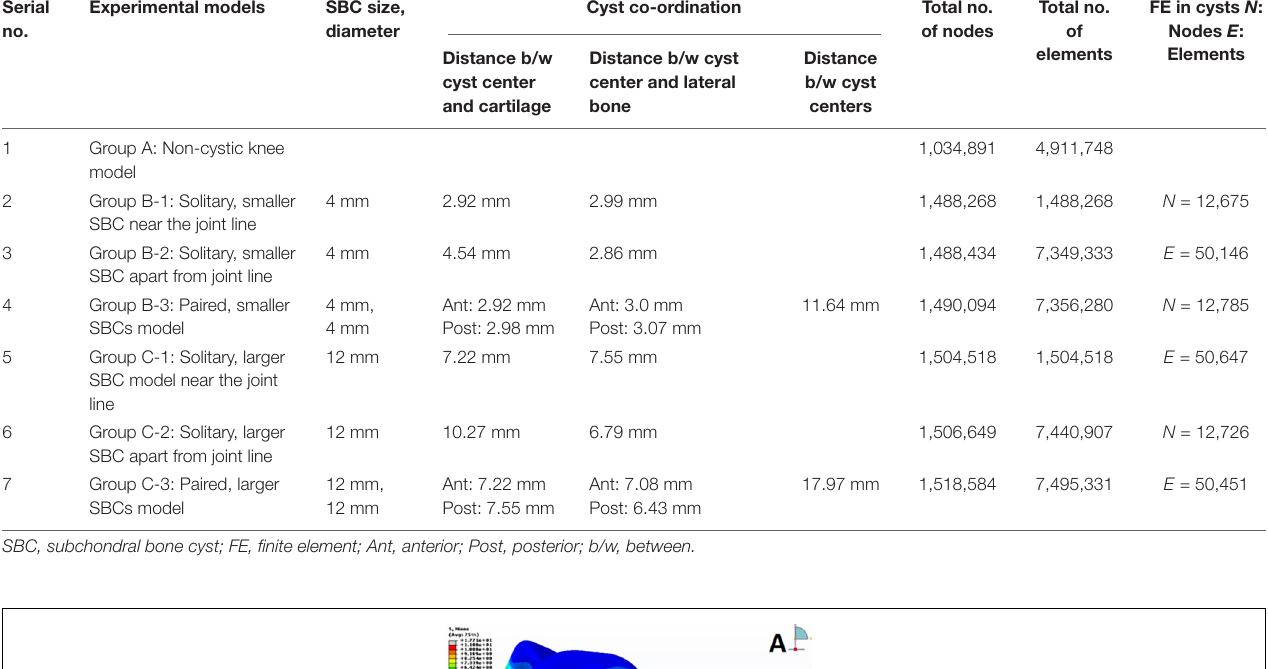
Frontiers in Bioengineering and Biotechnology |